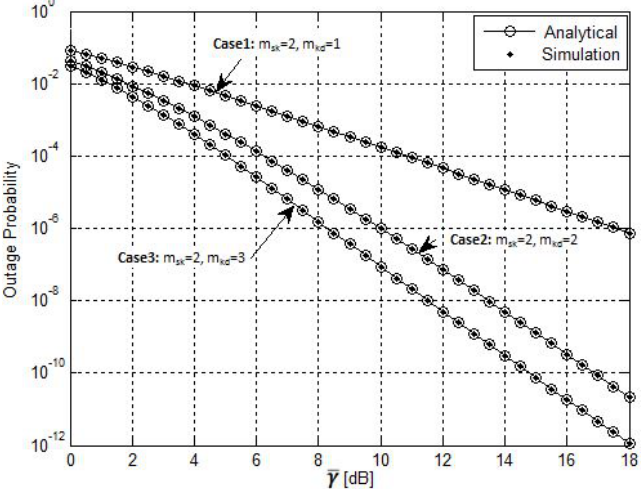
Figure 3. Impact of severity parameters on the system performance, ( N = 3).